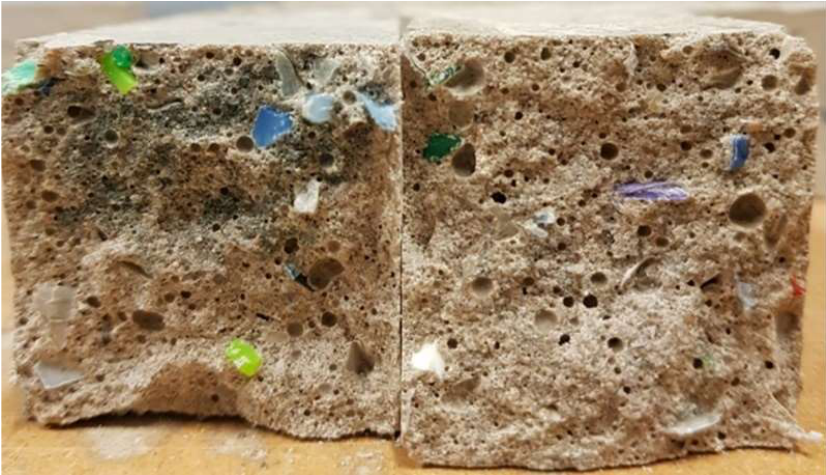
Figure 7. Cross sections of specimens (from left: mortars 10S80P and 10S40P).